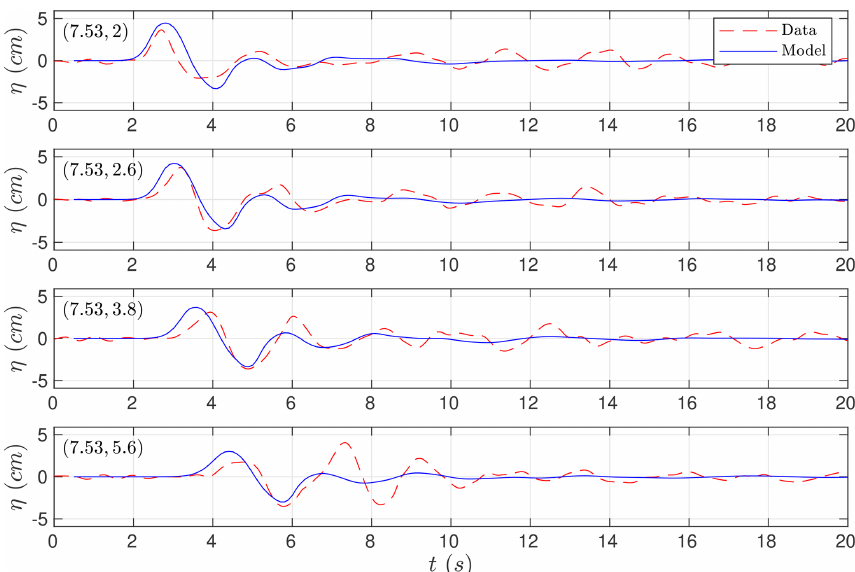
Figure 12. Time series comparing numerical run-up (solid blue) at the four run-up gauges with the measured (dashed red) data at ( x , y ) po-